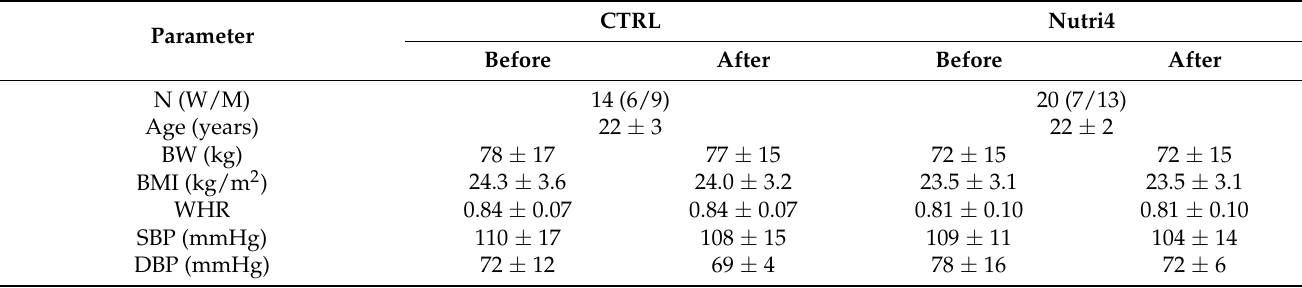
Table 2. The Effect of Regular and Nutri4 Hen Eggs Consumption on Anthropometric, Hemodynamic and Biochemical Parameters in Healthy